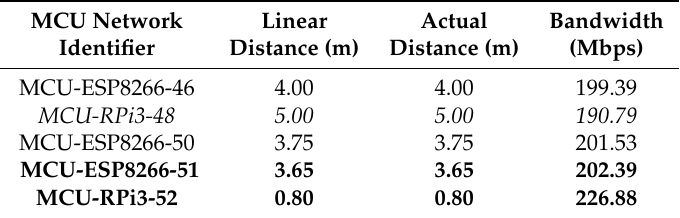
Table 3. LNR 49 ( t 0 ) or reliable nodes for the MCU-ESP8266-49, bold results indicate the two maximum bandwidth for MCU 49 ( t 0 ) , while italics highlight the lowest bandwidth for the same node.